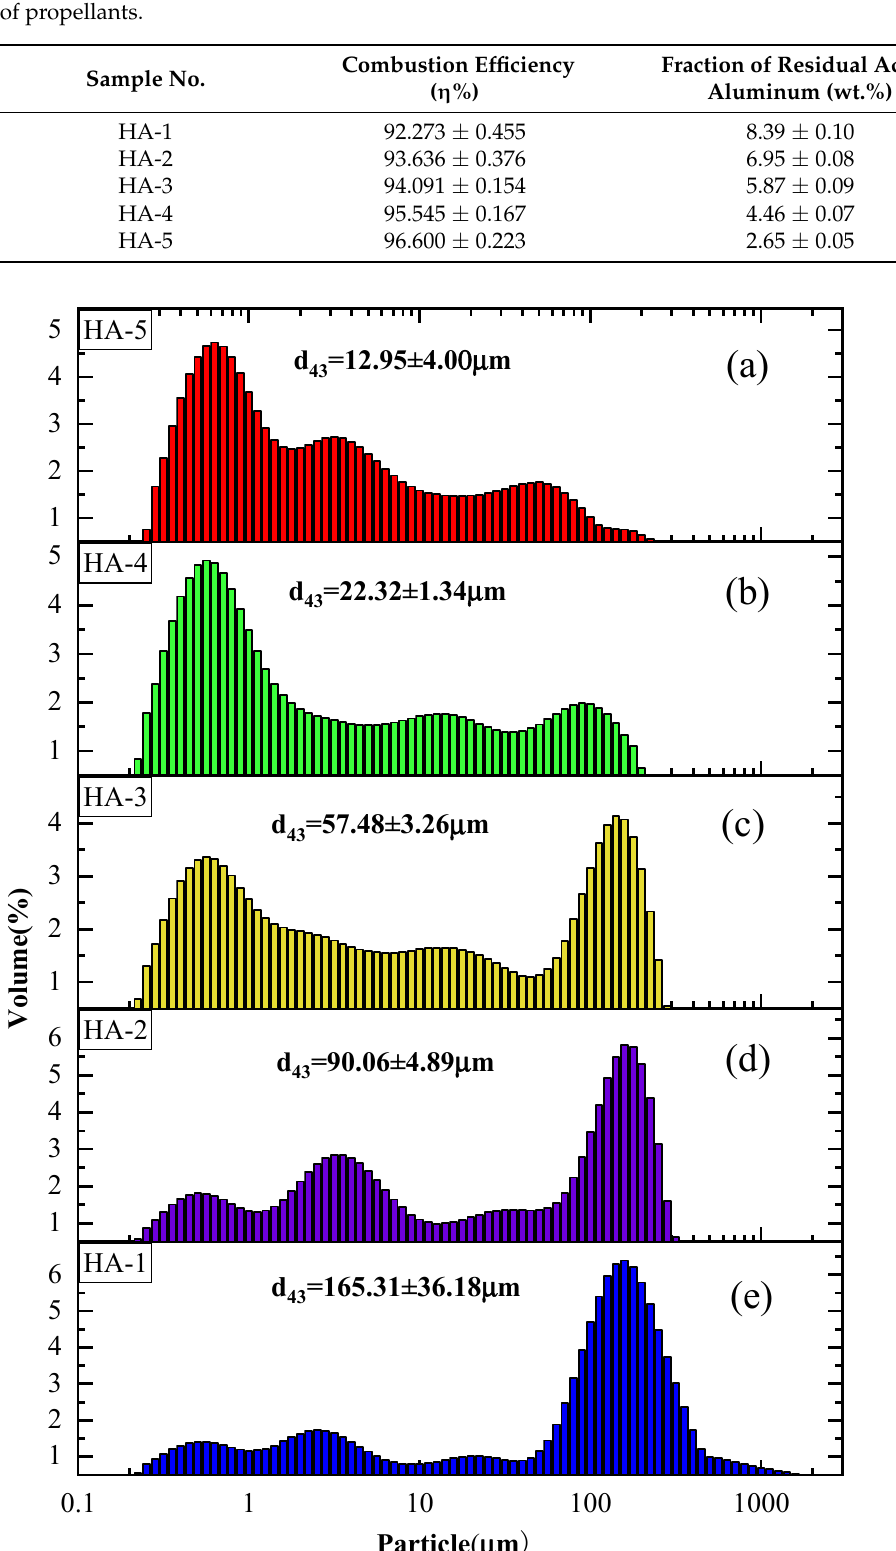
Figure 4. Size distribution of the combustion residue of the propellant: ( a ) HA-5; ( b ) HA-4; ( c ) HA-3; ( d ) HA-2; ( e ) HA-1.